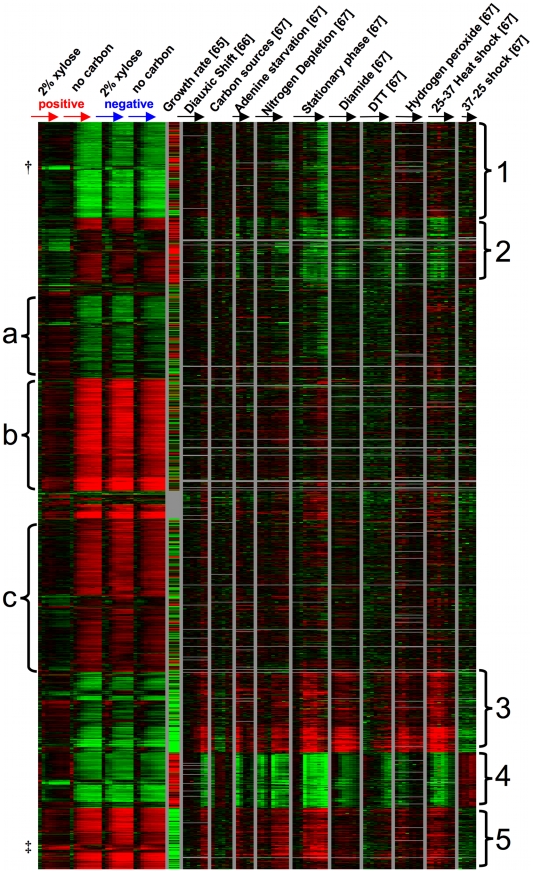
Gene expression timecourse.K-means (K = 10) clustering of gene expression values from this work and three other data sets. The 1,266 genes all changed significantly in this study in at least one two-class (paired timecourse) SAM analysis (see Results). Values from this study are time zero-transformed relative mRNA abundance (compared to a pooled reference of all samples from this work) and are averaged among 3 biological replicates at each time point. From left to right: xylose positive strain (2% xylose), xylose positive strain (no carbon source), xylose negative strain (2% xylose), xylose negative strain (no carbon source). “Growth rate” data were calculated by [65] and show the strength and direction of the transcriptional response of a given gene to a higher growth rate. “Diauxic shift” are zero-transformed data from [66], and all other data are from [67]; again all time-courses are zero-transformed. (†,‡ indicate small subgroups discussed in Results.)